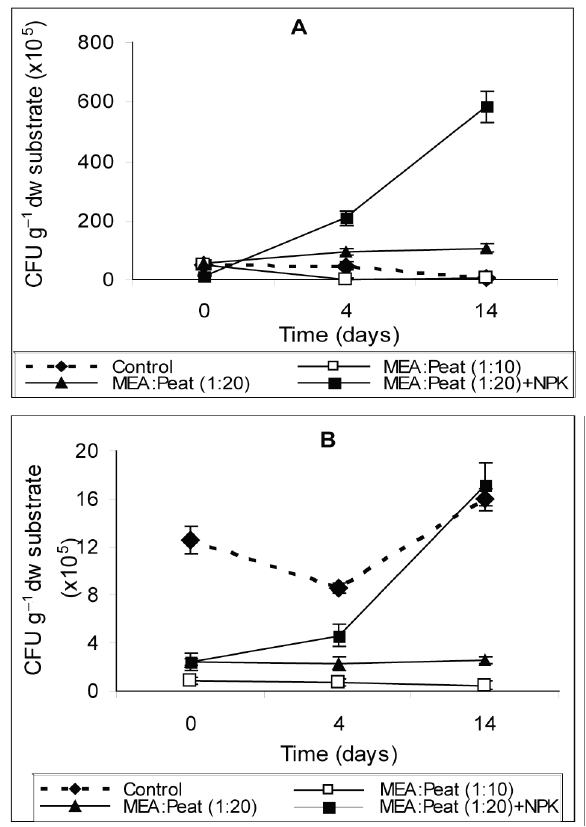
Fig. 3. The number of micromycetes in MEA and peat (A – pH 3,1; B – pH 6,3) mixed substrata Table 4. Viability of wheat and rye seeds (%) in MEA and peat mixed substrata Rye Wheat Mixed substrata Peat (MEA: peat) After 4 days After 14 days After 4 days After 14 days pH